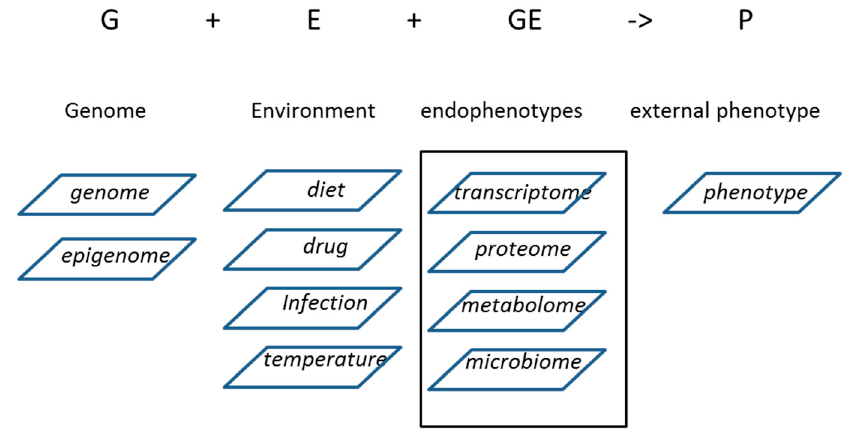
Figure 1. Genotype and environment affect the endophenotypes of an animal, and together, they regulate the external phenotype, or trait.